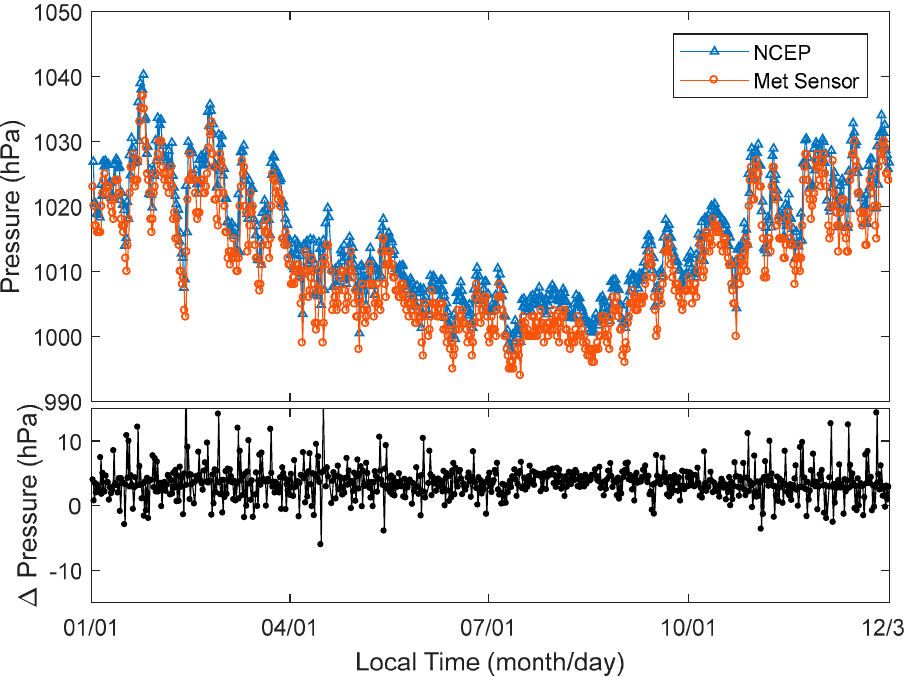
Figure A7. The atmospheric pressure time series from NCEP and radiosonde at GPS Keqi station and HAZH radiosonde station, respectively.